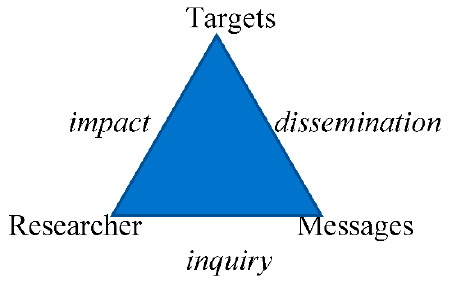
Figure 1. Socio-scientific triad.